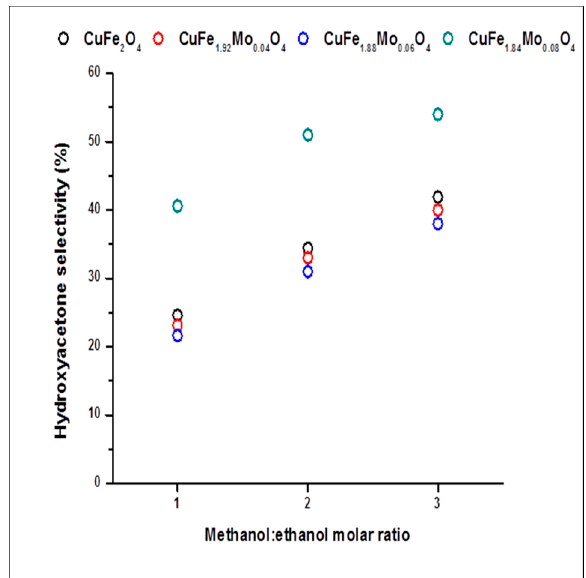
Figure 7. Catalytic performance of copper molybdenum ferrites in the oxidative coupling between methanol and ethanol as function of the methanol to ethanol molar ratio (reaction conditions: temperature 300 ◦ C; liquid fed 0.1 cm 3 / min; air flow 3000 cm 3 / min; catalyst amount 0.1 g).( a ) ethanol conversion, selectivity of ( b ) ethyl-methyl ether, ( c ) methyl-acetate, ( d ) ethyl-acetate, ( e ) hydroxyacetone